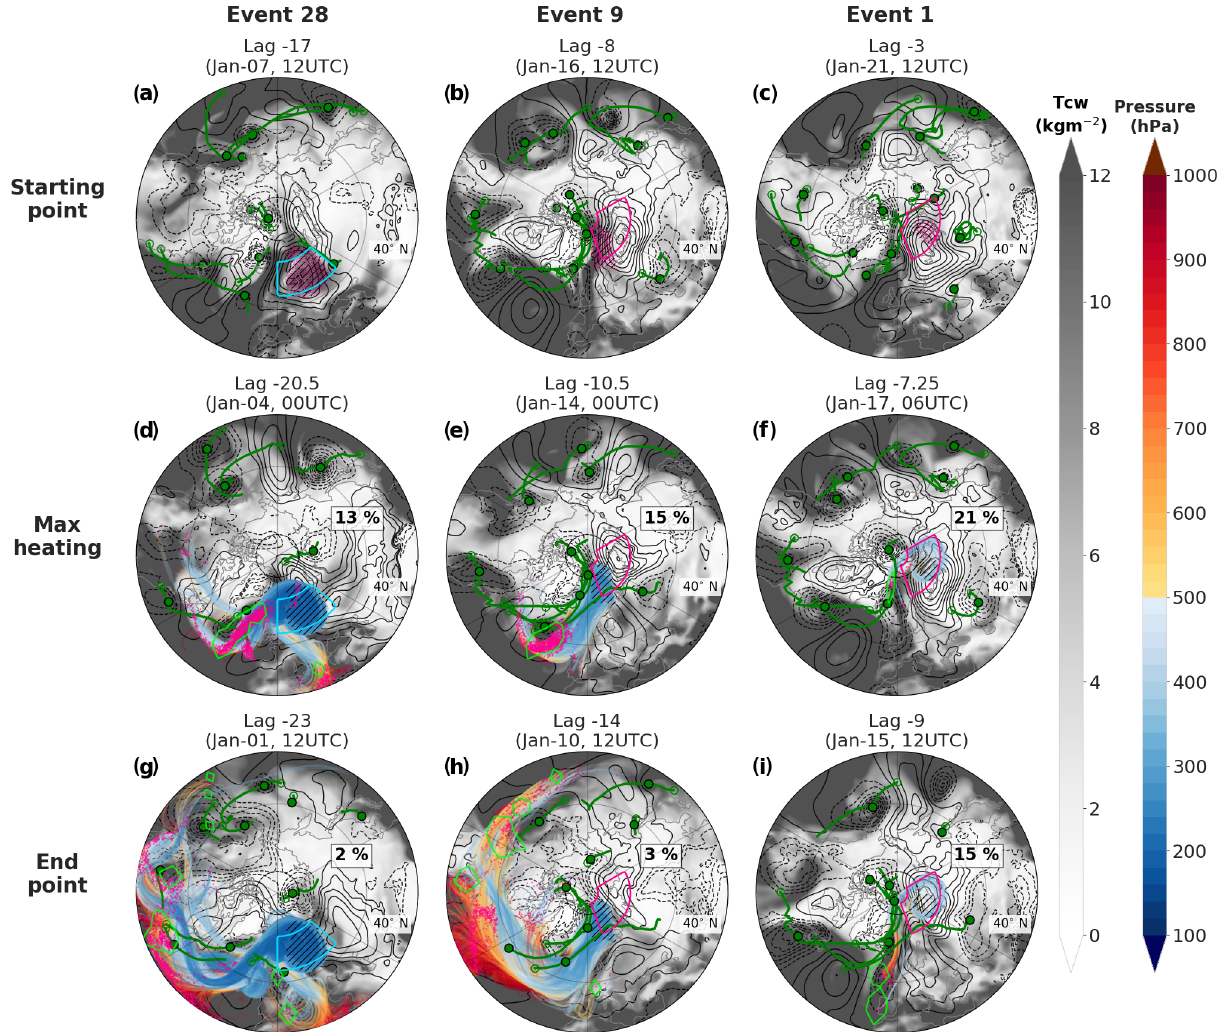
Figure 4. Six day back trajectories initialized from the blocks (black hatched regions, first row) prior to the three warm events (columns). Rows indicate the trajectory locations (pink dots) at the starting point (a–c) , the time of maximum diabatic heating (d–f) and the end point (g– i) . The dates for which the panels are valid are denoted by lag days relative to the peak of the warmest event 1. Furthermore, the trajectories are drawn between the valid time and the starting time, colored according to pressure. Additionally shown are total column water (gray shading, kgm − 2 ), SLP anomalies (hPa, black contours every 5hPa, dashed for < 0hPa, zero contour not shown), and cyclone location at valid time (green dot) and tracks (green lines). Further shown is the density of trajectories experiencing maximum heating at the valid time (green contour for 5%(10 6 km 2 ) − 1 ). The relative percentage of all heated trajectories experiencing their maximum heating at the valid time is given in the text boxes (second and third rows). The latitude circle at 40 ◦ N is indicated by a black dashed line, and the magenta and blue boxes indicate the Ural and Scandinavian blocking sectors,